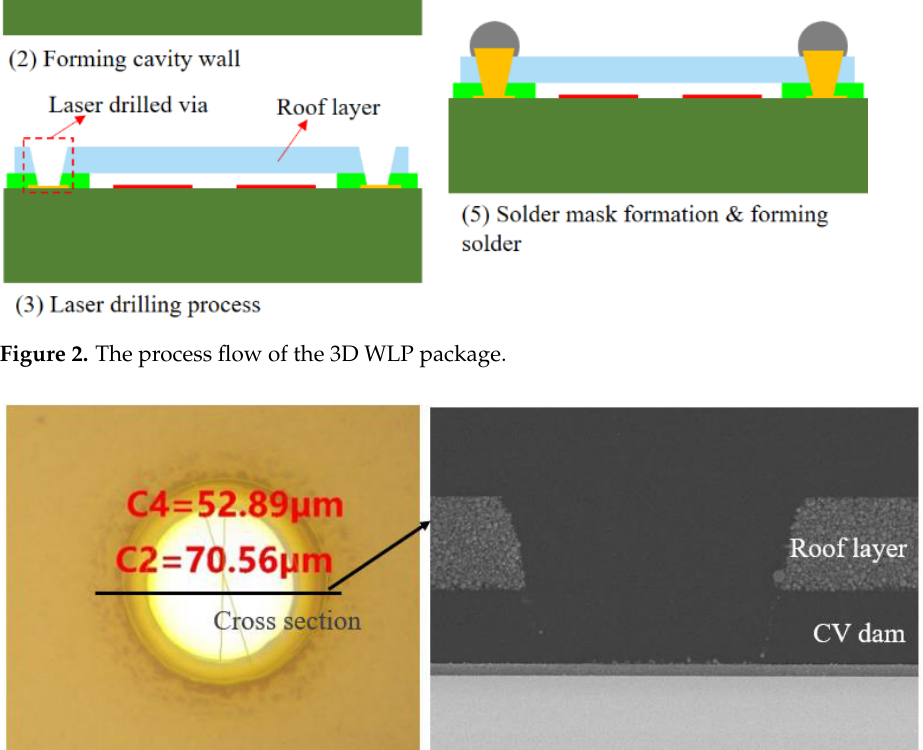
Figure 5. Collapse of the SAW WLP package. In general, a mismatch in the coefficient of thermal expansion (CTE) between differ- ent materials in a WLCSP structure can induce high thermal stress. Because the perfor- mance of the package may be impacted by the design structure and material characteris- tics, such as the thickness of the vias sidewall Cu plating and material properties of both the CW dam and roof layer, it is necessary to investigate the impact of these aspects. To ensure reliability, for a SAW filter WLP, it was necessary for us to investigate the causes of typical failure models and optimize the package structure to meet the reliability requirements of consumer electronics. 3. FE Model of a SAW Filter ’s WLP 3.1. Single-Die FE Model to Solve the RDL Crack Failure Mode To investigate the stress distribution of Cu RDL traces, an FE model was constructed to calculate the maximum primary stress at each phase of the manufacturing process flows, focusing on the different Cu thicknesses of the vias sidewall at the steady-state cooling process (temperature conditions varied from 260 °C to 22 °C) to achieve high de- pendability [22,23]. The package structure model was developed and simplified into four parts in this model, as illustrated in Figure 6, comprising the RDL, roof layer, CW dam layer, and SAW device substrate (from top to bottom), and the material properties are listed in Table 1.